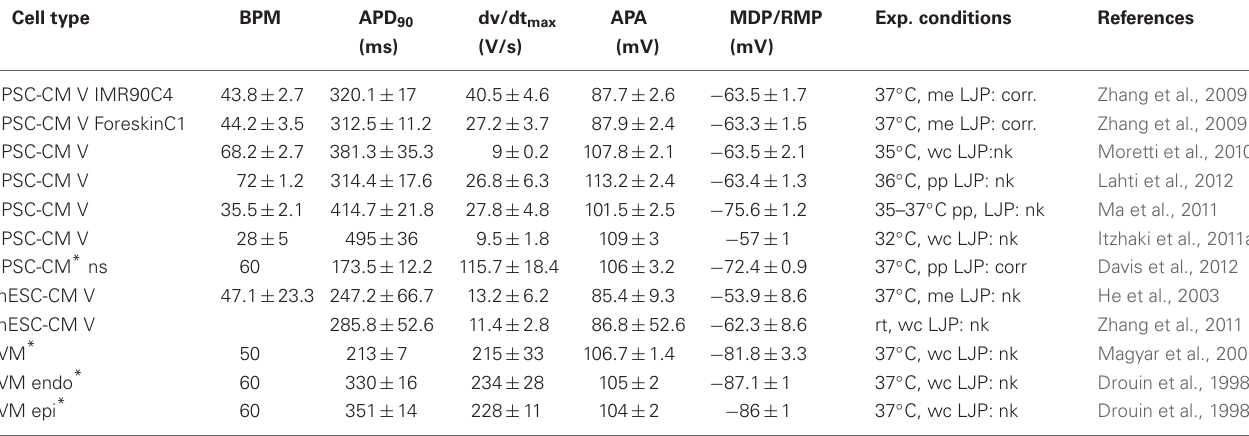
Table 1 | Action potential characteristics in hiPSC-CM and human ventricular